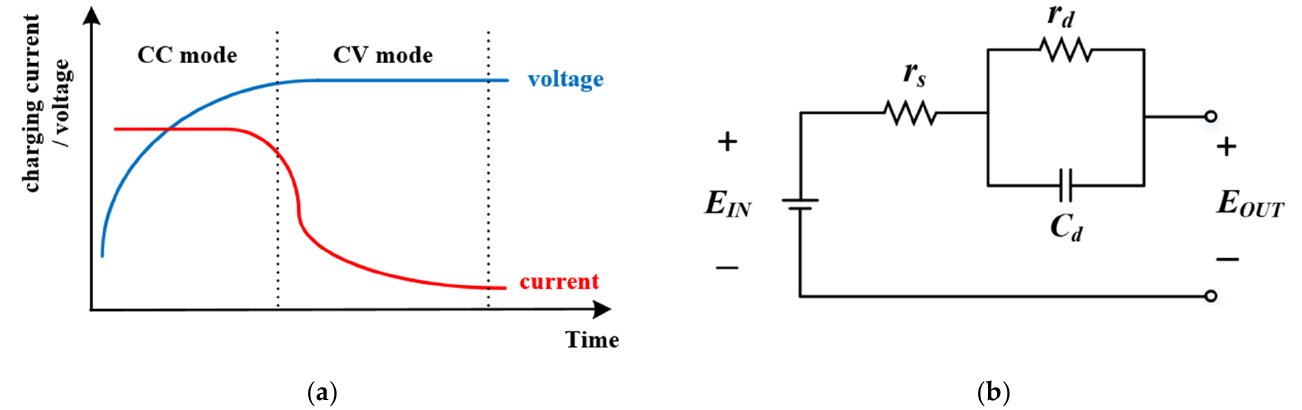
Figure 2. ( a ) CC-CV graph; ( b ) simplified battery equivalent circuit .